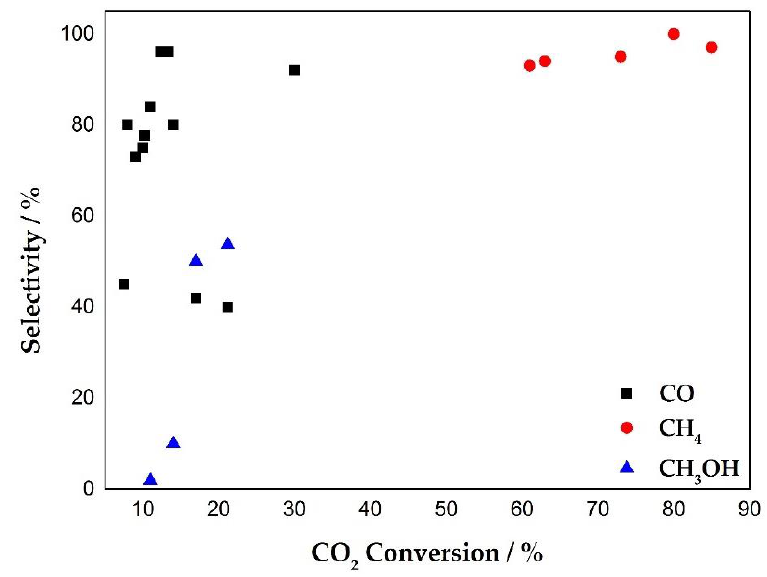
Figure 24. Overview of selectivity into CO, CH 4 , and CH 3 OH, as a function of CO 2 conversion, based on all reports available in literature about plasma catalysis (all in DBD reactors). The references where these data are adopted from are discussed in the